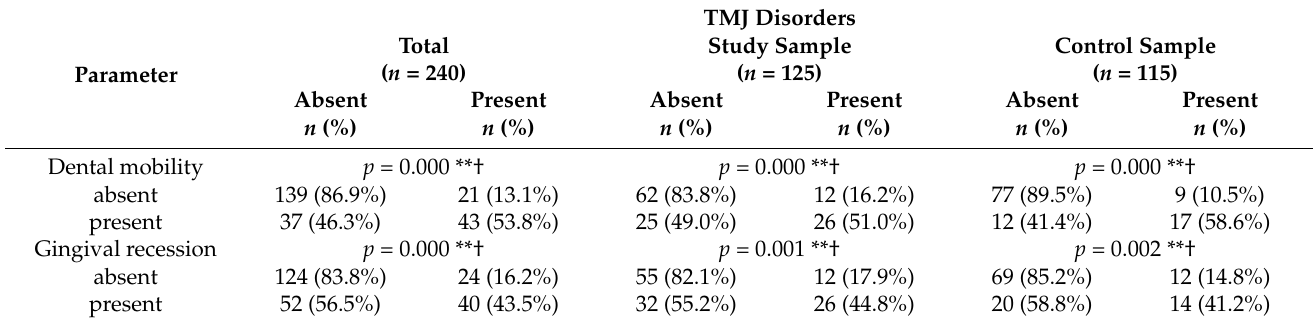
Table 4. The TMJ disorders presence by dental mobility and gingival recession in the investigated